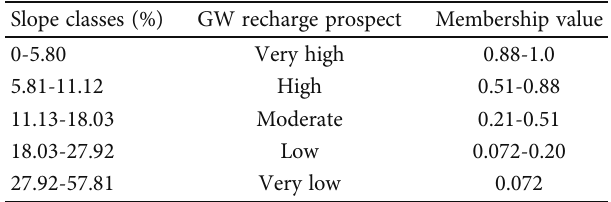
Table 2: Slope classes, membership value, and